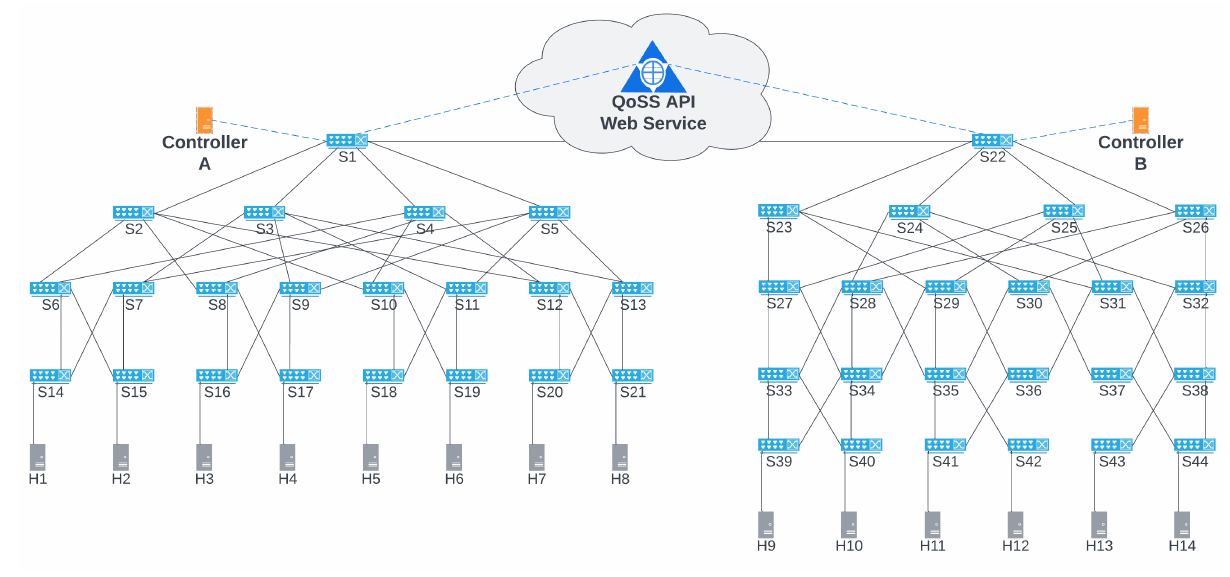
Figure 5. Experimental topology.